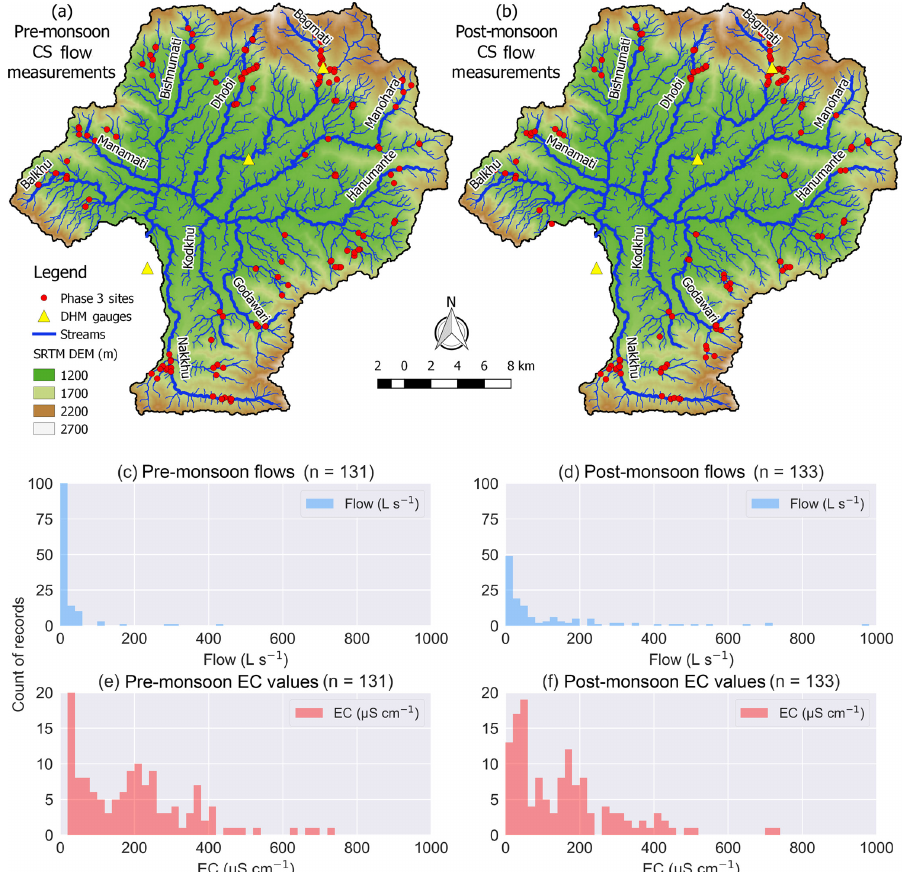
Figure 6. CS Flow campaign measurement locations ( n = 131 pre-monsoon; n = 133 post-monsoon) within the Kathmandu Valley for (a) pre- and (b) post-monsoon. Histograms show distributions of measured flows in Ls − 1 (c, d) and EC inµScm − 1 (e, f) . Bins are set to 20 units wide for both flow and EC. Three flow measurements for the post-monsoon (d) that were above 1000Ls − 1 are not shown: 1059, 1287, and 1804. Three Department of Hydrology and Meteorology (DHM) gauging stations are shown as yellow triangles.